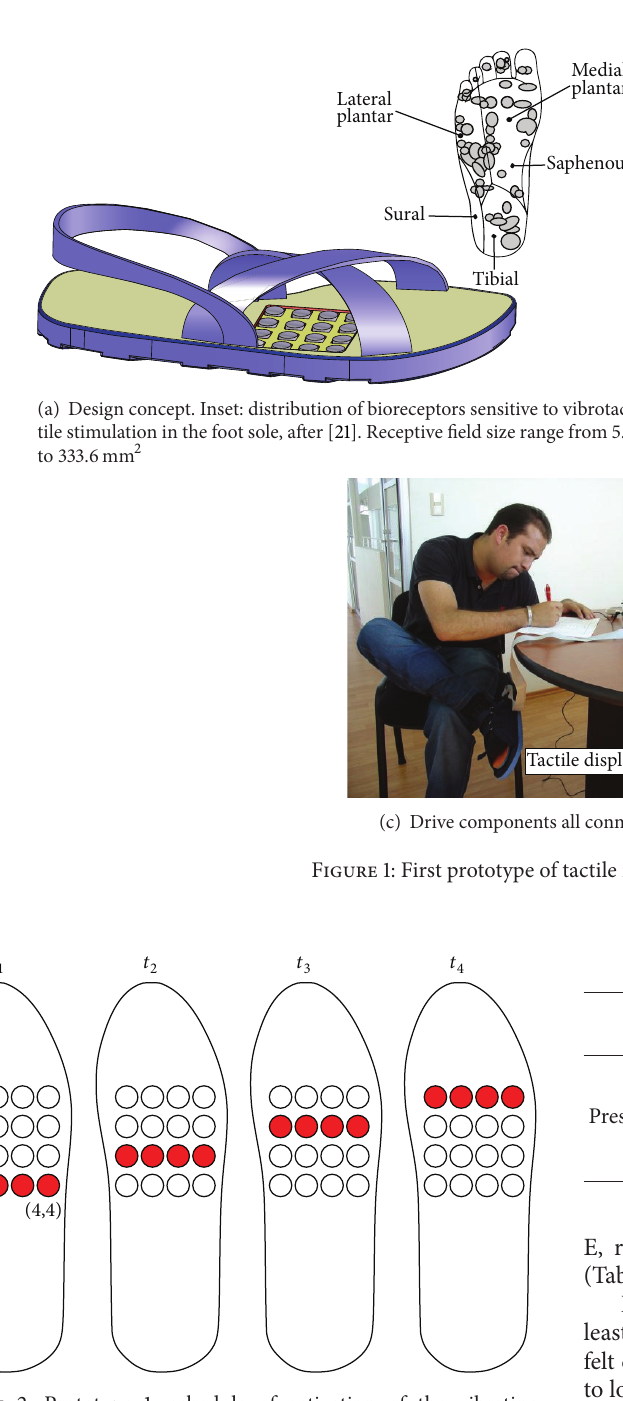
Figure 2: Prototype 1: schedule of activation of the vibrating actuators for the direction recognition task. Example for North.